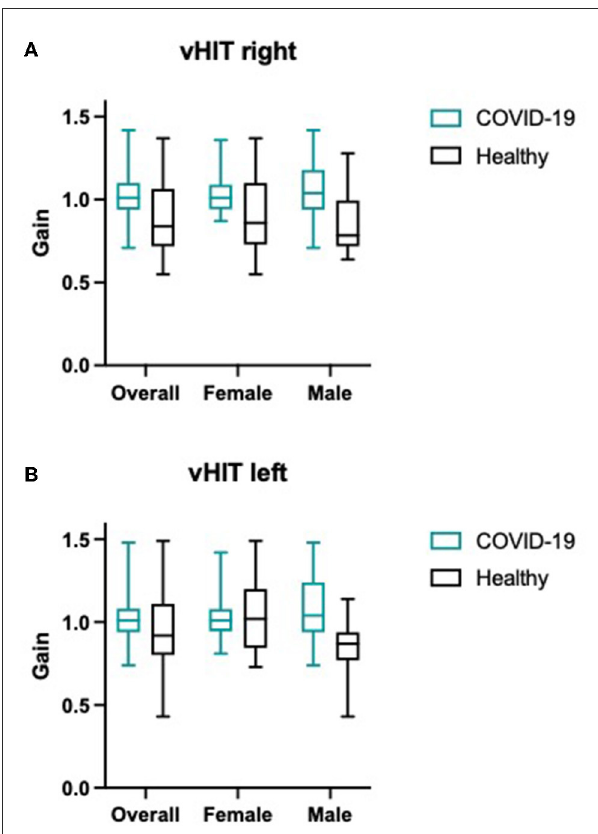
FIGURE1 (A) vHIT results (median and range) for right and left horizontal canal and (B) SVV results (median deviation of true vertical) for overall patients, female and male participants are shown for COVID-19 cohort as well as for control